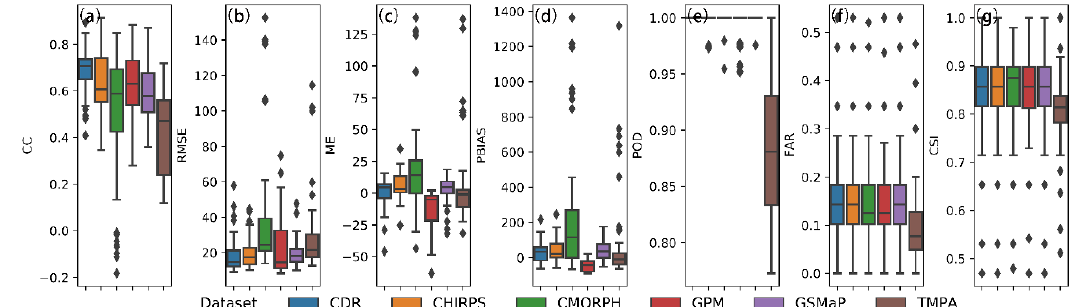
Figure 2. The performance of daily data in different evaluation indexes. (The point represents the outlier. For the whiskers, the upper and lower boundaries represent the maximum value and minimum value, respectively. For the boxes with color, the top, middle and bottom black lines represent first quartile value, median value, and third quartile value, respectively.) ( a ) Correlation coefficient, ( b ) root mean square error, ( c ) mean error, ( d ) percentage bias, ( e ) probability of detection, ( f ) false alarm ratio, ( g ) critical success index.